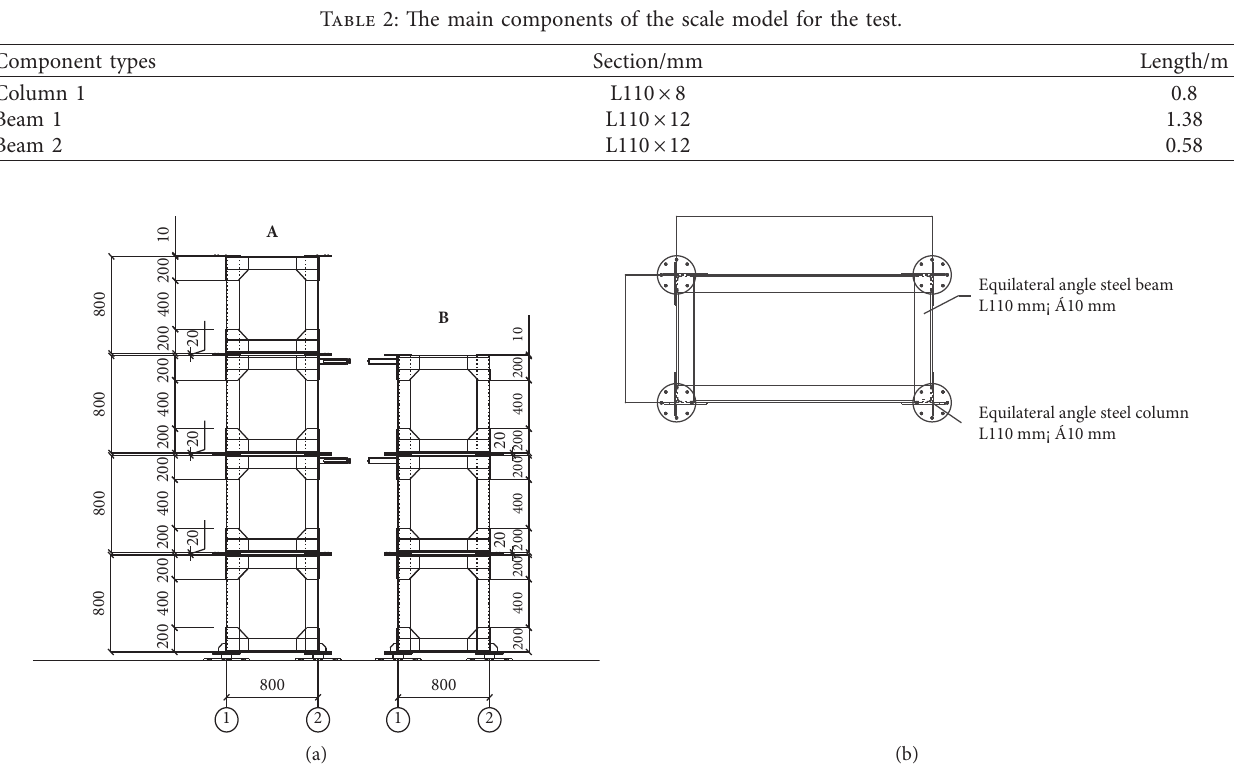
Figure 7: Detailed dimension diagram of the scale model. (a) Elevation of the scale model. (b) Top view of the scale